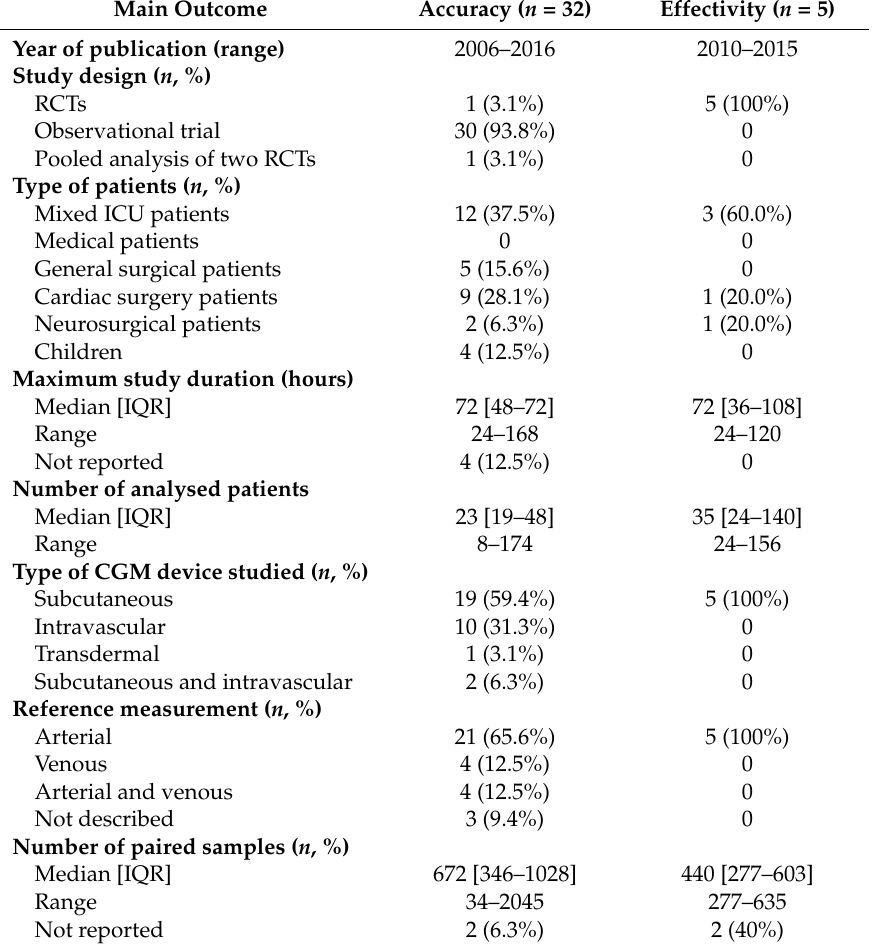
Table 1. Descriptives of the included articles by their main outcome ( n =